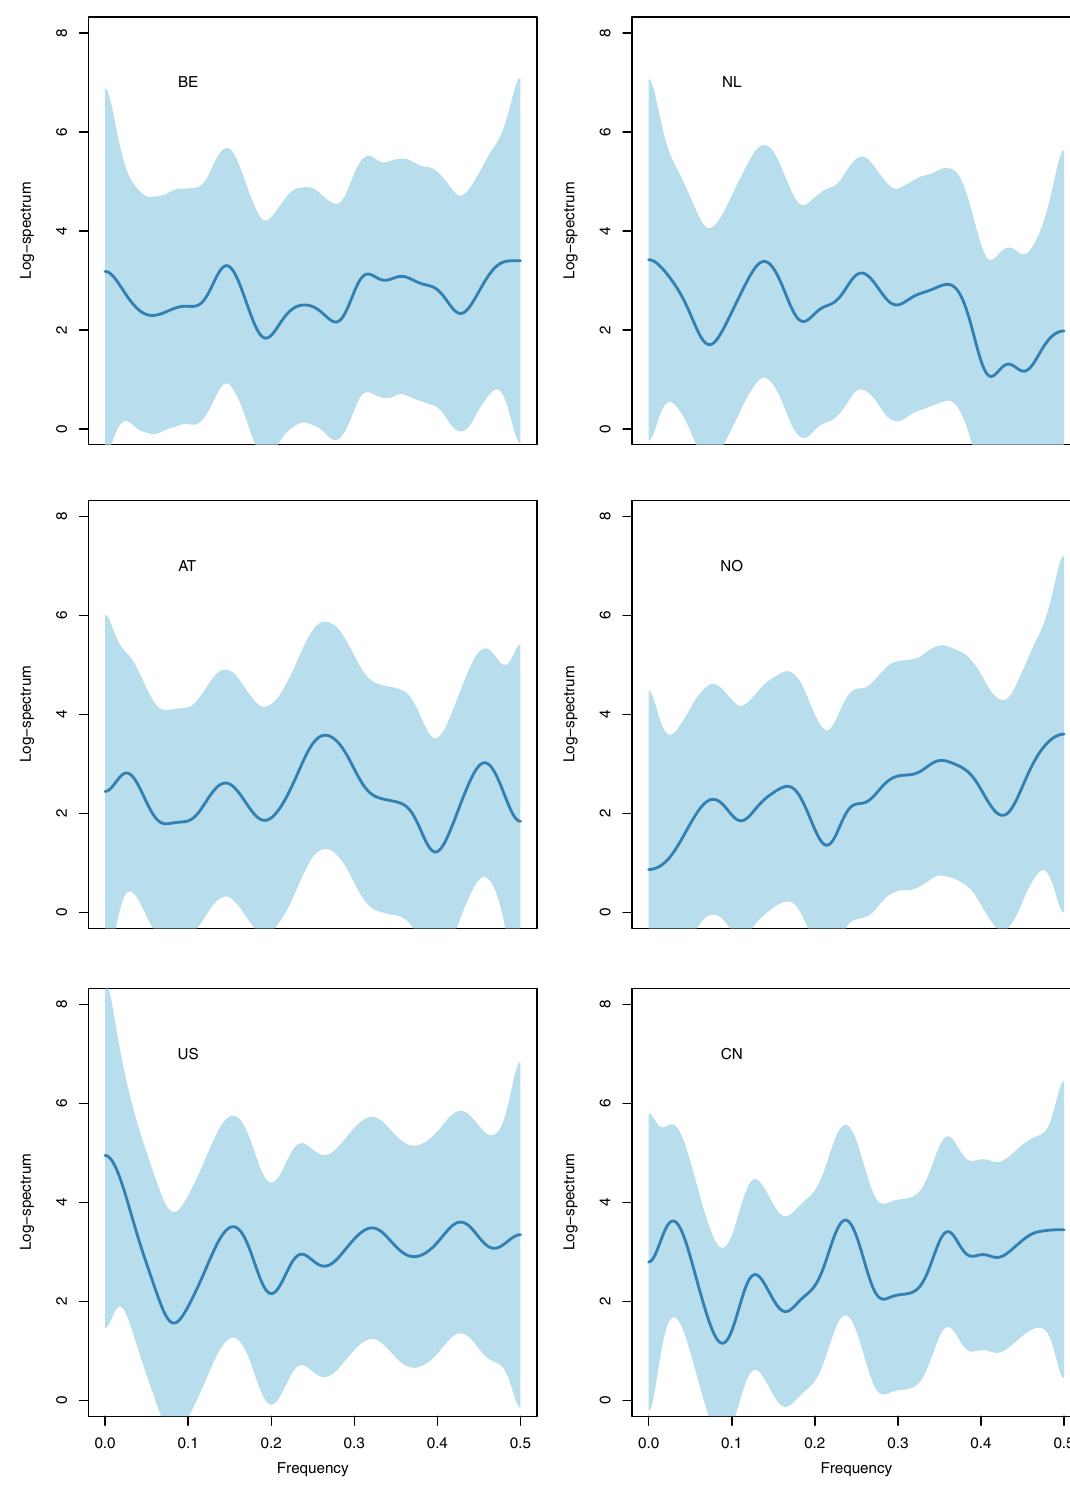
Figure 8. Regspec spectral estimates for numbers of new daily COVID-19 cases. Top-to-bottom, left-to-right: Belgium on 43 days, the Netherlands on 45 days, Austria on 49 days, Norway on 47 days, the USA on 53 days, China on 87